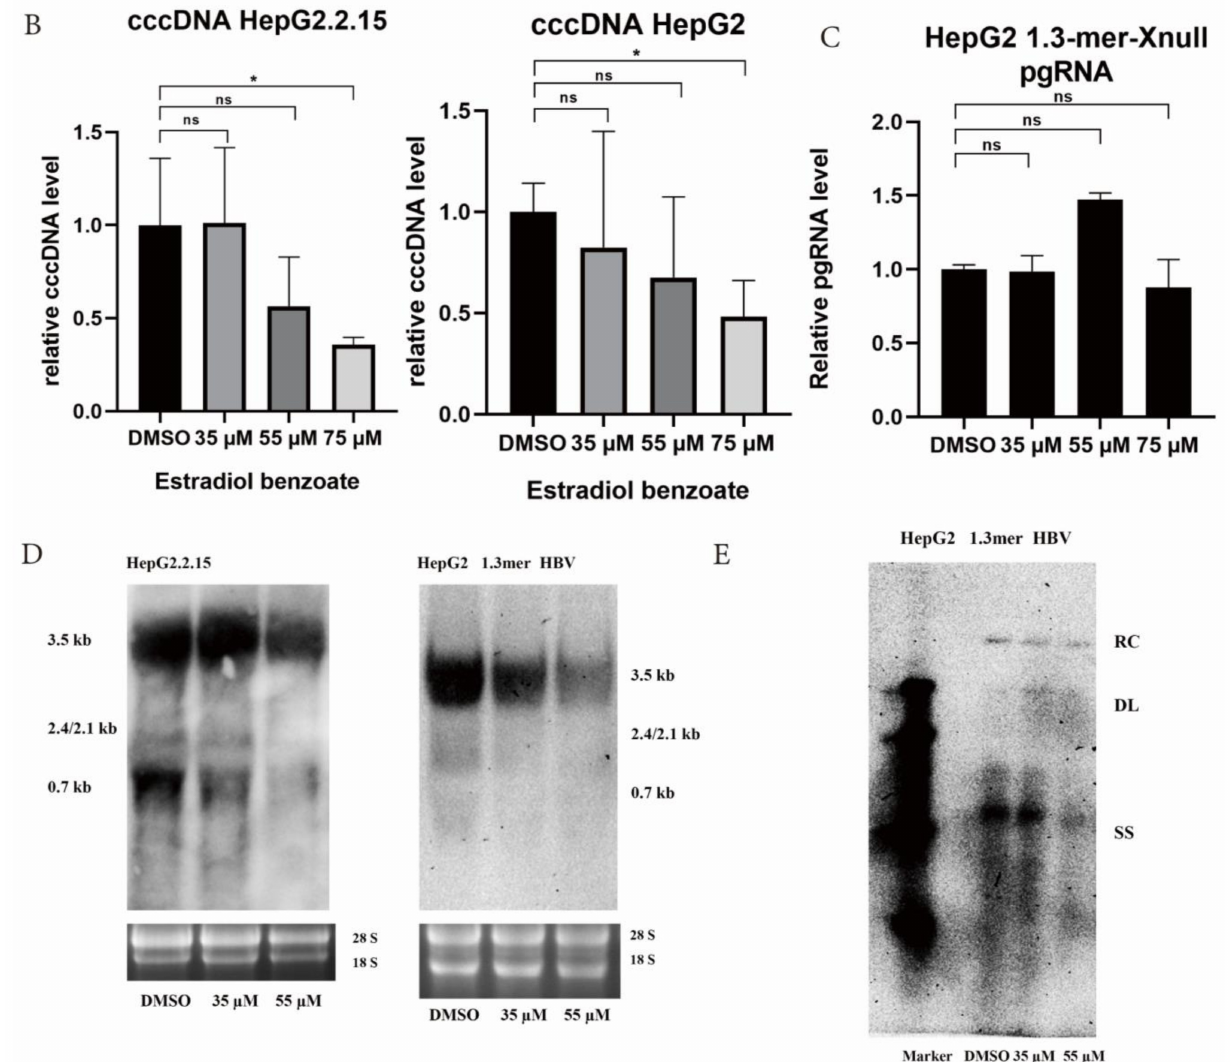
Figure 3. Estradiol benzoate inhibits HBV replication and transcription. ( A ) RT-qPCR of pgRNA level of estradiol benzoate– and 17 β -estradiol–treated HepG2.2.15 cells and 1.3mer HBV–transfected HepG2 cells. ( B ) qPCR results of intracellular cccDNA of estradiol benzoate–treated HepG2.2.15 cells and 1.3mer HBV–transfected HepG2 cells. ( C ) Relative pgRNA level of estradiol benzoate–treated 1.3mer HBV X-null transfected HepG2 cells. ( D ) Northern blot results of estradiol